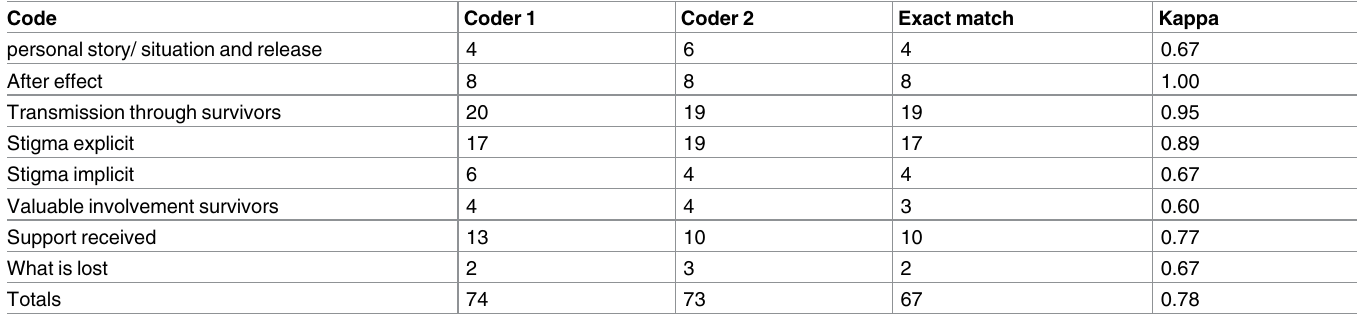
Table 1. Kappa strength of